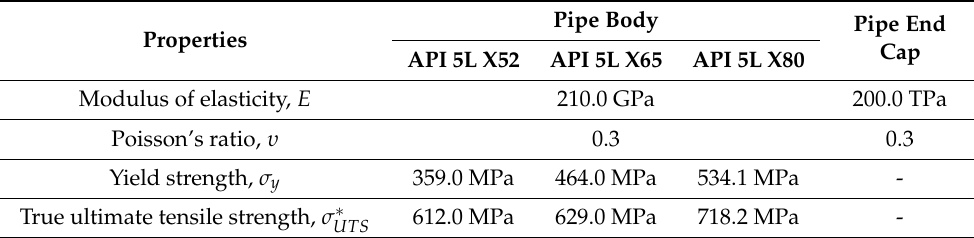
Table 3. Material properties of the pipe grades used in this study [5,7,20].